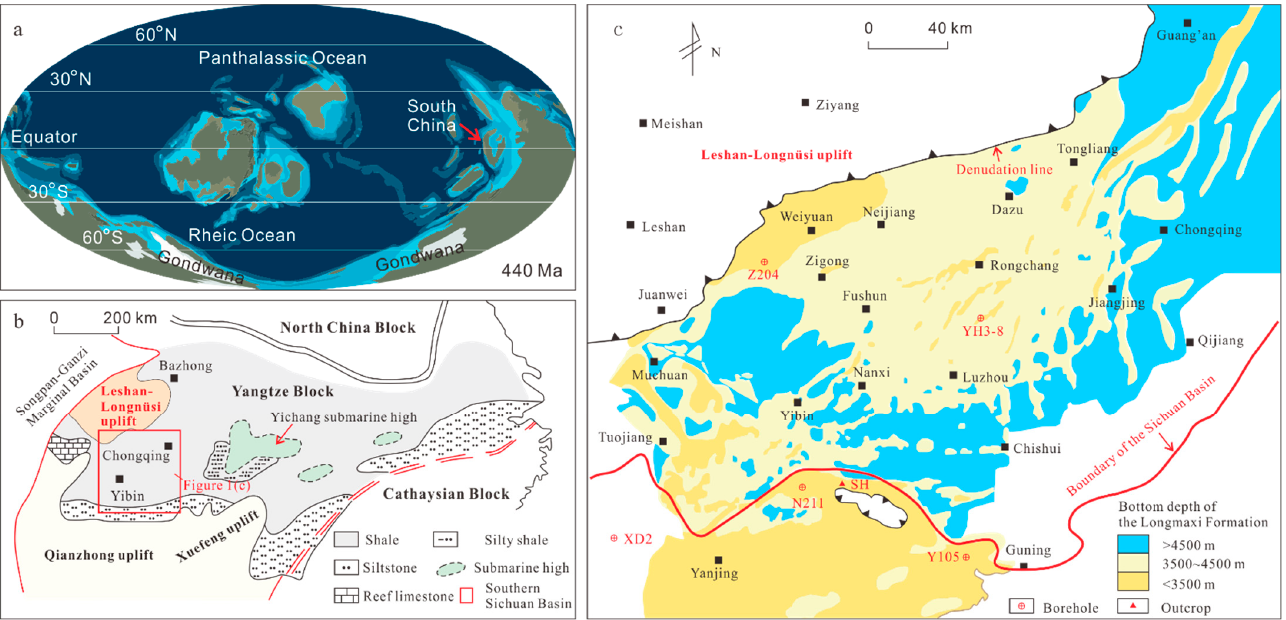
Figure 1. ( a ) Global paleogeography during the Early Silurian (the map originates from https://deeptimemaps.com (accessed on 18 July 2022)); ( b ) paleogeographic map of the Yangtze shelf sea during the Early Silurian showing the location of the southern Sichuan Basin (modified from [37]); ( c ) the bottom depth of the Longmaxi Formation of the southern Sichuan Basin (modified from [43]) (For interpretation of the references used to color in this figure legend, the reader is referred to the Web version of this article).